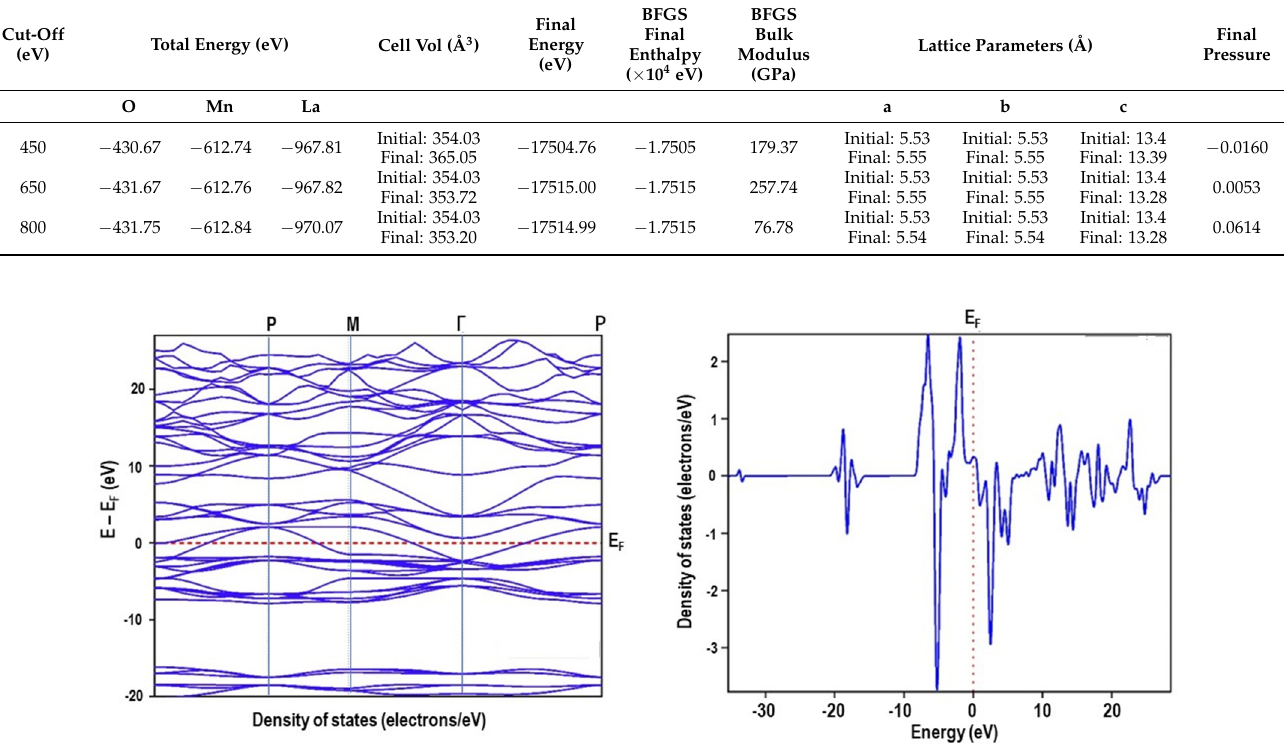
Figure 10. CASTEP GGA–PBE band structure and DOS of rhombohedral perovskite LaMnO 3 . 4. Conclusions Lanthanum manganite, LaMnO 3 , was synthesized using a glycol–thermal synthesis method without the use of a chelating agent. This involved the mixture of La and Mn nitrates which yielded perovskite powder with reduced particle sizes (D TEM = 19, 39, 45, and 90 nm) and high surface areas of 33.1, 14.6, 6.6, and 2.2 m 2 /g for LM 700, LM 800, LM 900, and LM 1000, respectively. Implementing DFT first-principles calculations, a success- ful analysis of the physical properties of ideal cubic and rhombohedral structure showed the optimized cell structure of LaMnO 3 perovskite. When compared to the theoretical data, the experimental results showed that the unit cell lattice of the synthesized powder transitioned from the cubic phase to a rhombohedral perovskite structure at a higher